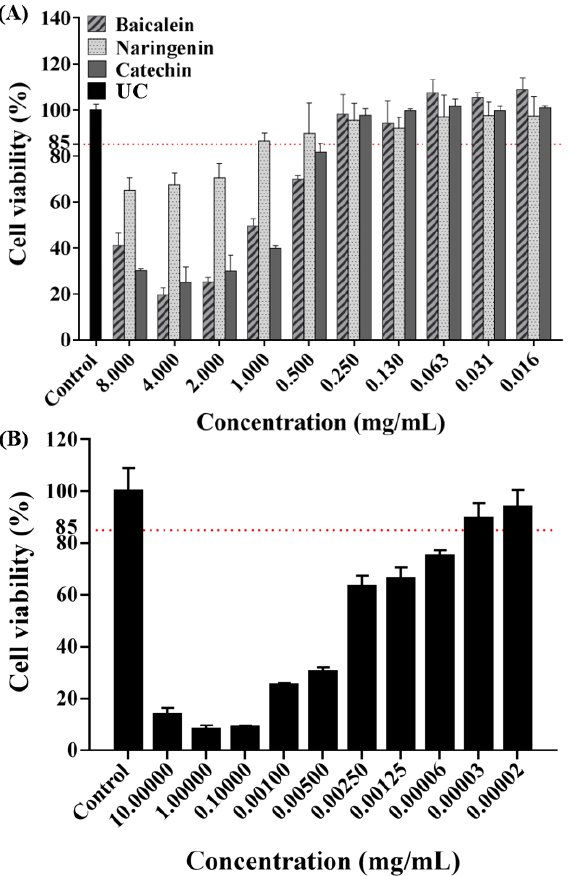
Figure 1. Cell viability tests of HOK cells after being exposed to flavonoids ( A ) or CHX; ( B ) (mean ± sd; n = 3).